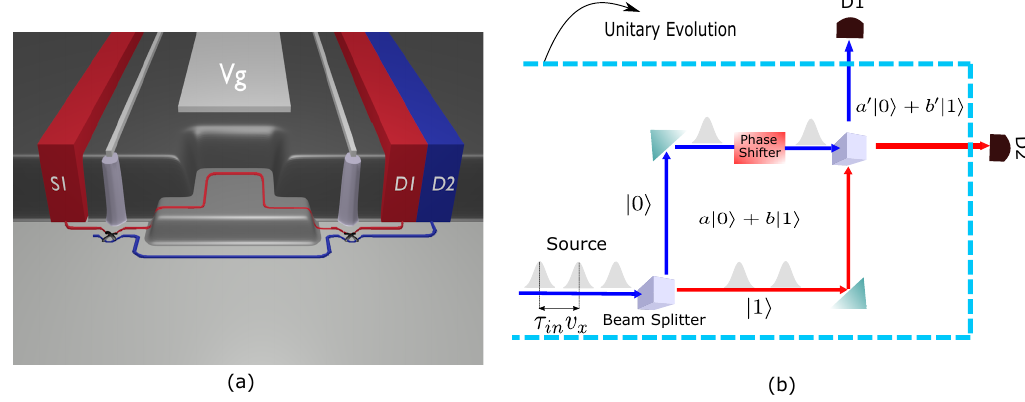
Figure 4. ( a ) 3D view of the potential landscape felt by the electrons in the MZI at bulk filling factor 2 in the Integer Quantum Hall regime, in presence of a perpendicular magnetic field [34]. Electrons are injected in the first edge channel by the source S 1 , and collected at the end of the device by the drain D 1 ( D 2 ) . The paths of the electrons in the interferometer is defined by the red (blue) line for the first (second) Landau level. ( b ) Schematic diagram and functioning of the MZI. Electron injection with non-interacting and non-overlapping wavepackets is shown in gray, while the region encapsulated by the cyan color dashed line box defines the region where the unitary evolution of the quantum states is